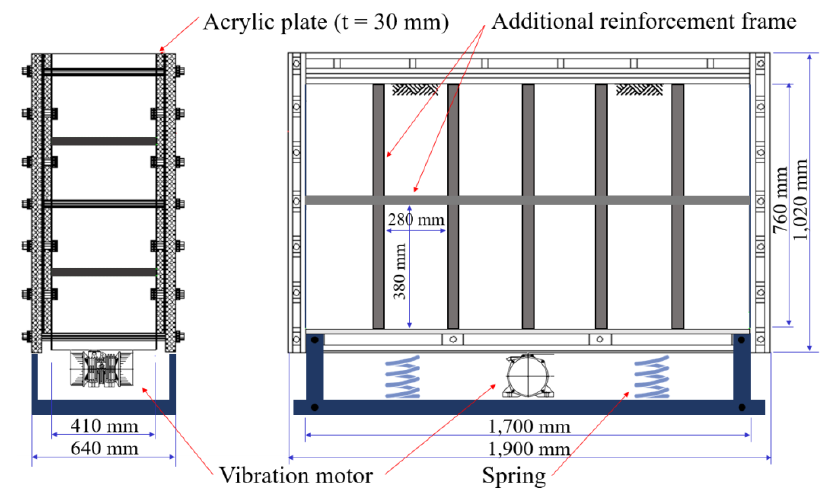
Figure 3. Plain strain soil tank (PSST): side view and front